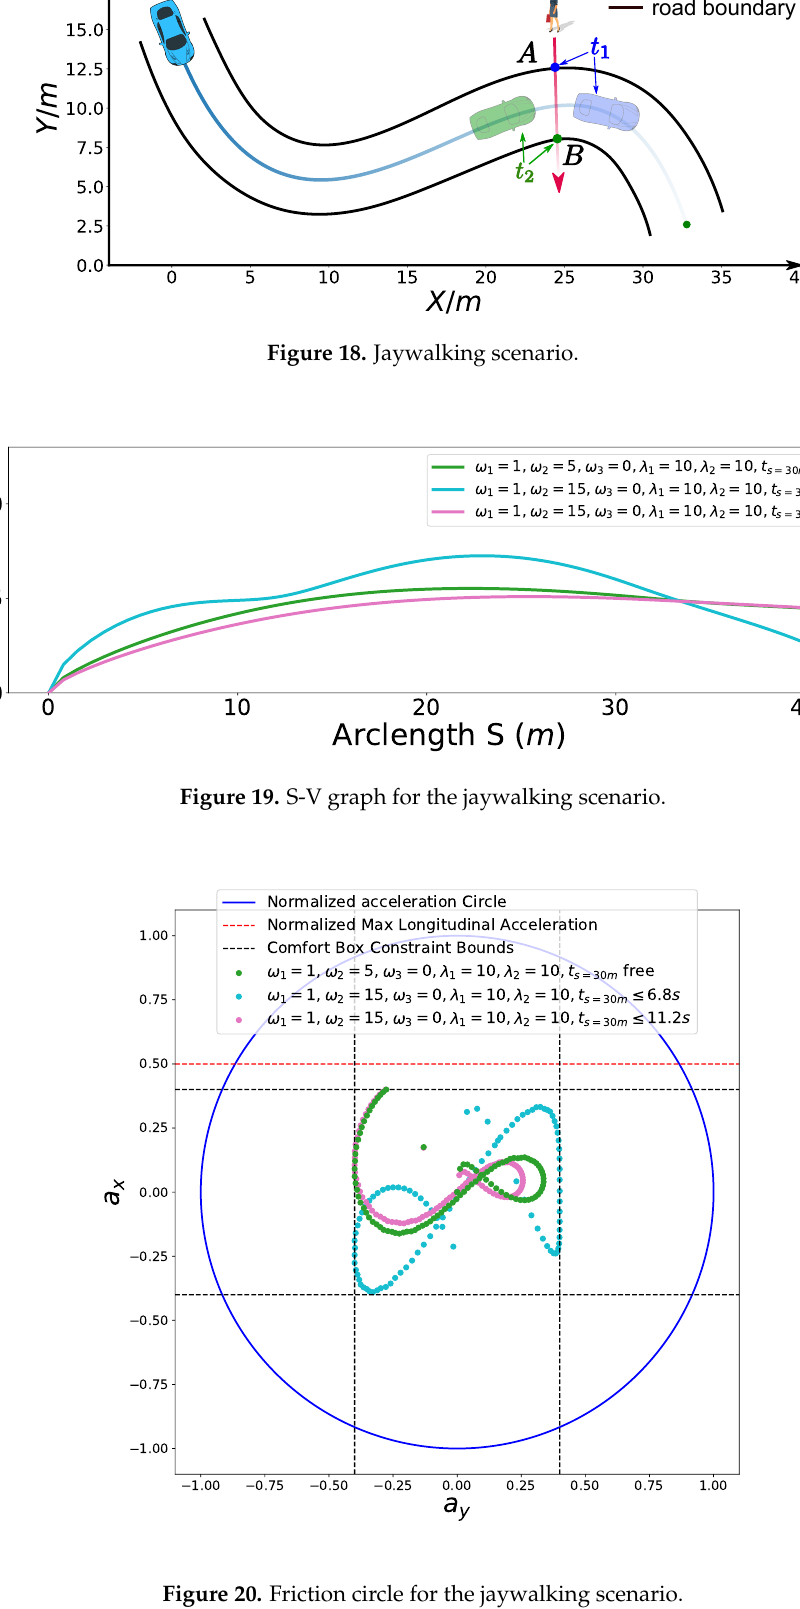
Figure 20. Friction circle for the jaywalking